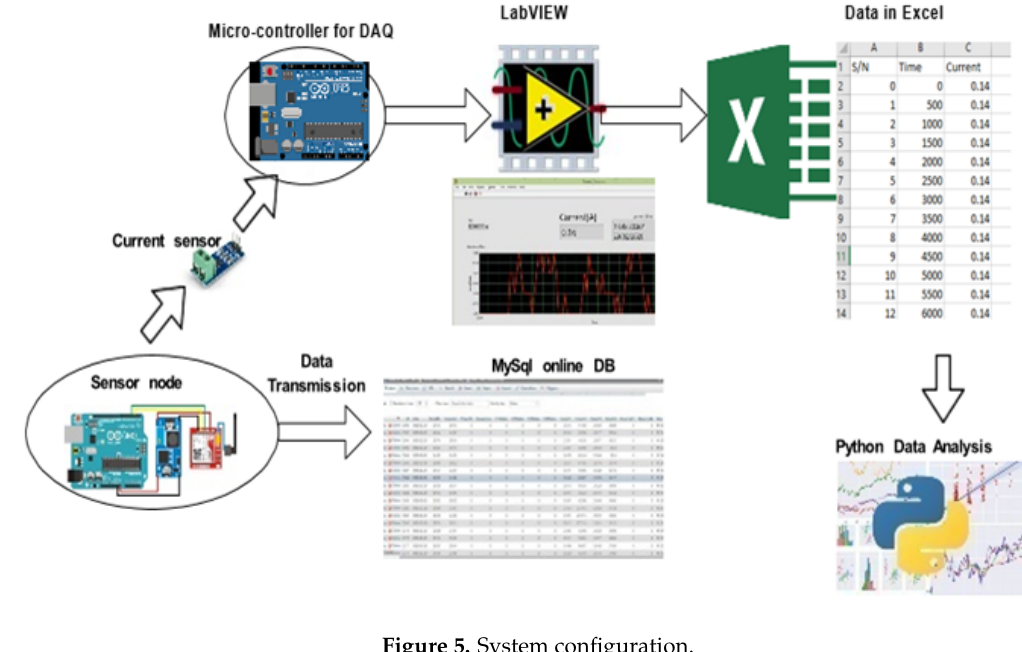
Figure 5. System